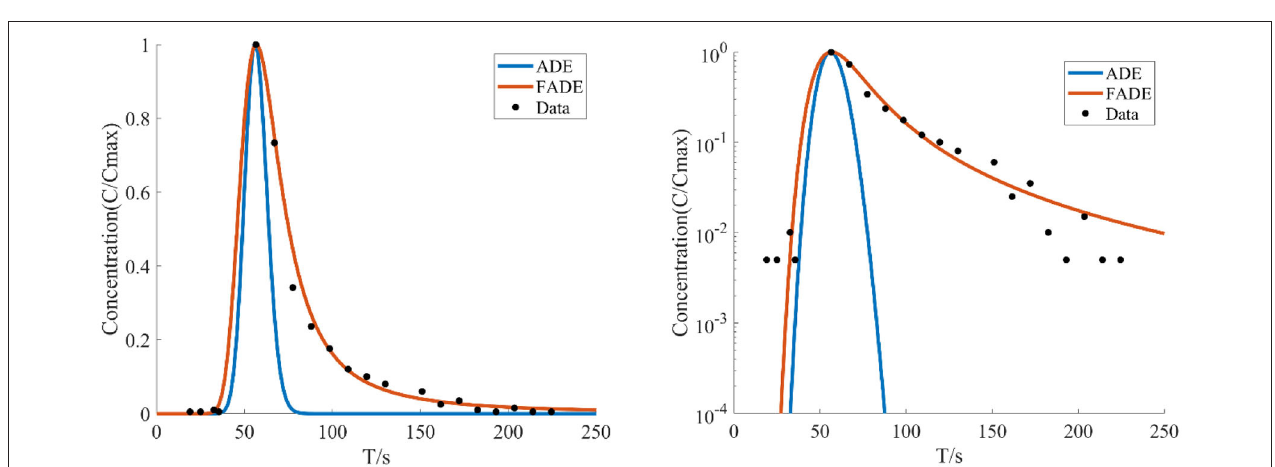
FIGURE 1 | The average flow velocity is v = 6.785 mm/s, the crack width is B = 4mm, and the breakthrough curves (BTCs) fitted by ADE model and FADE model is used.